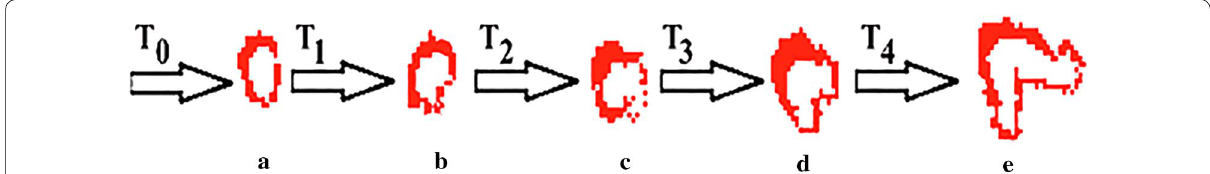
Fig. 1 Aspergillus fumigatus conidiospore outgrowth phases from germination to hypha formation and ramification visualized by